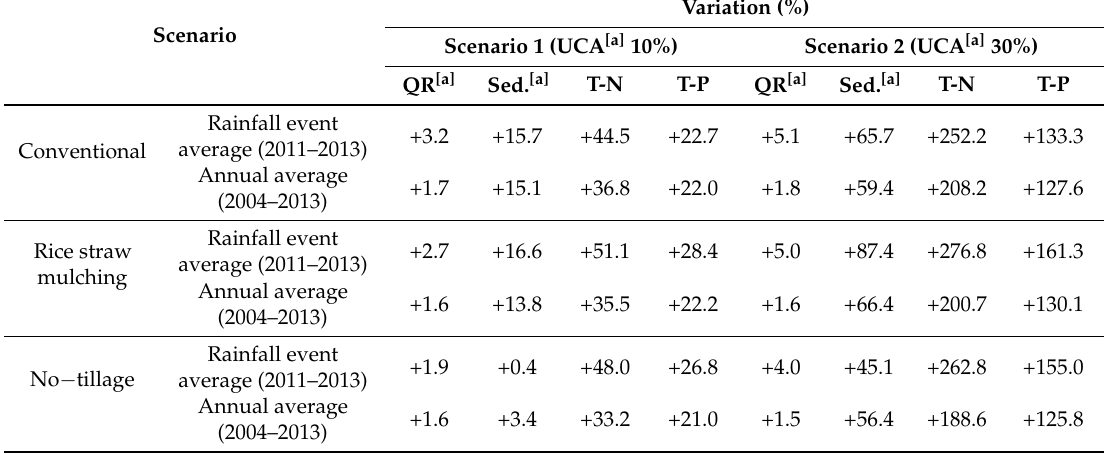
Table 6. Variation of runoff and NPS pollution for rainfall events and annual averages of the hourly simulated results for conventional, rice straw mulching and no-tillage applications when applying change scenarios of upland crop areas in the model